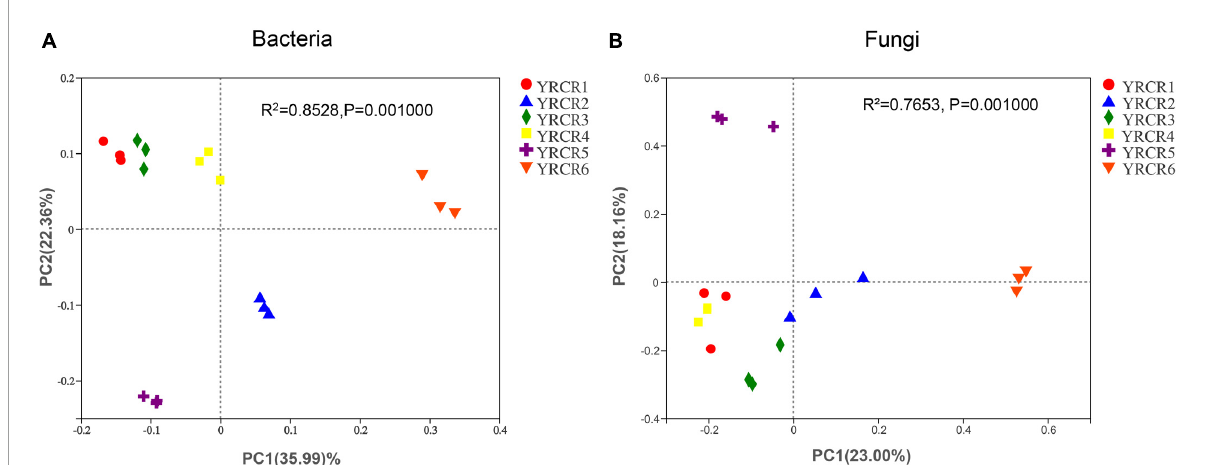
FIGURE5 (A) Is principal coordinate analysis (PCoA) of the bacterial diversity. (B) Is principal coordinate analysis (PCoA) of the fungal diversity. The hierarchical clustering and PCoA plots were using Bary–Curtis distance method at OUT level.